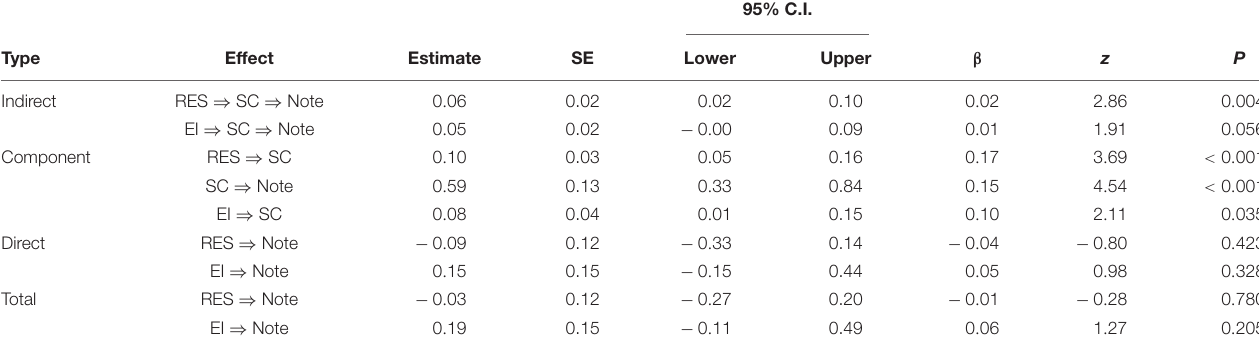
FIGURE 1 | Theoretical mediational model. TABLE 2 | Indirect and total effects on mediational analysis.